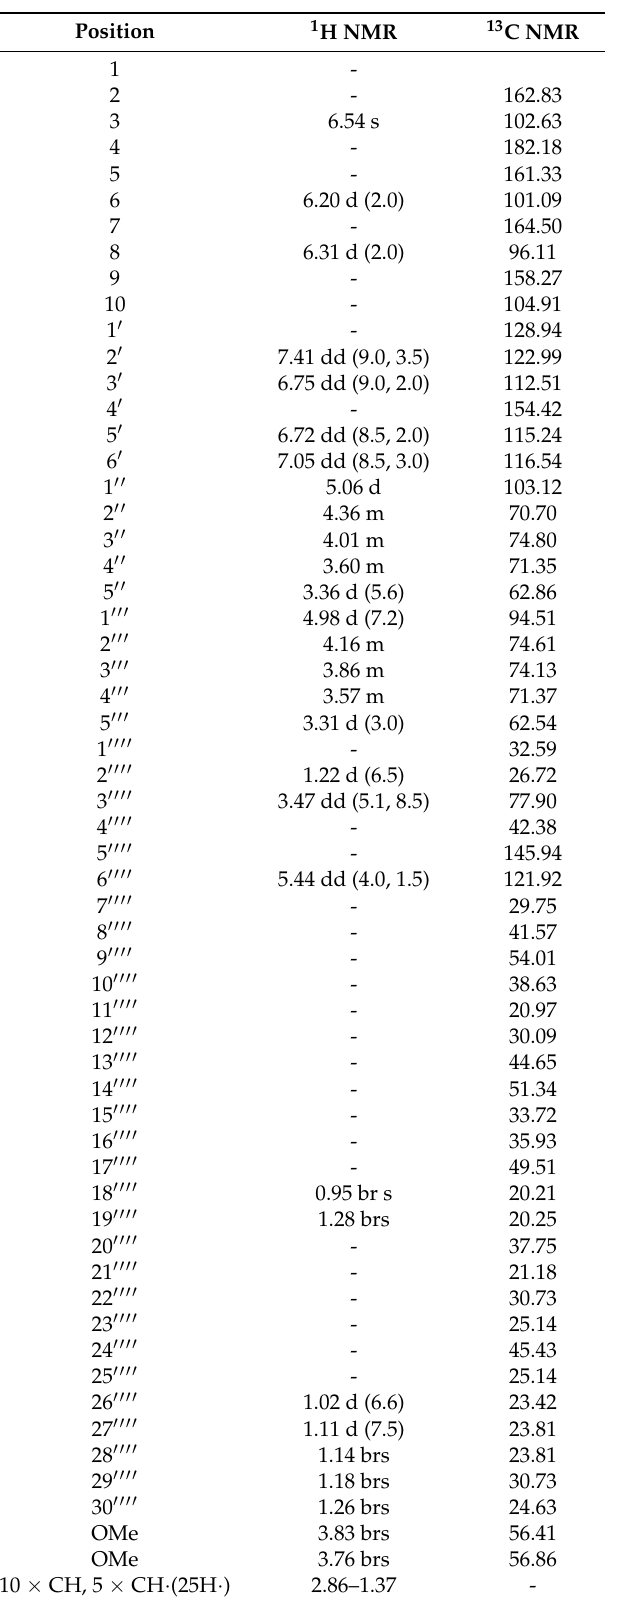
Table 3. 1 H NMR and 13 C NMR Spectroscopic data of compound 3